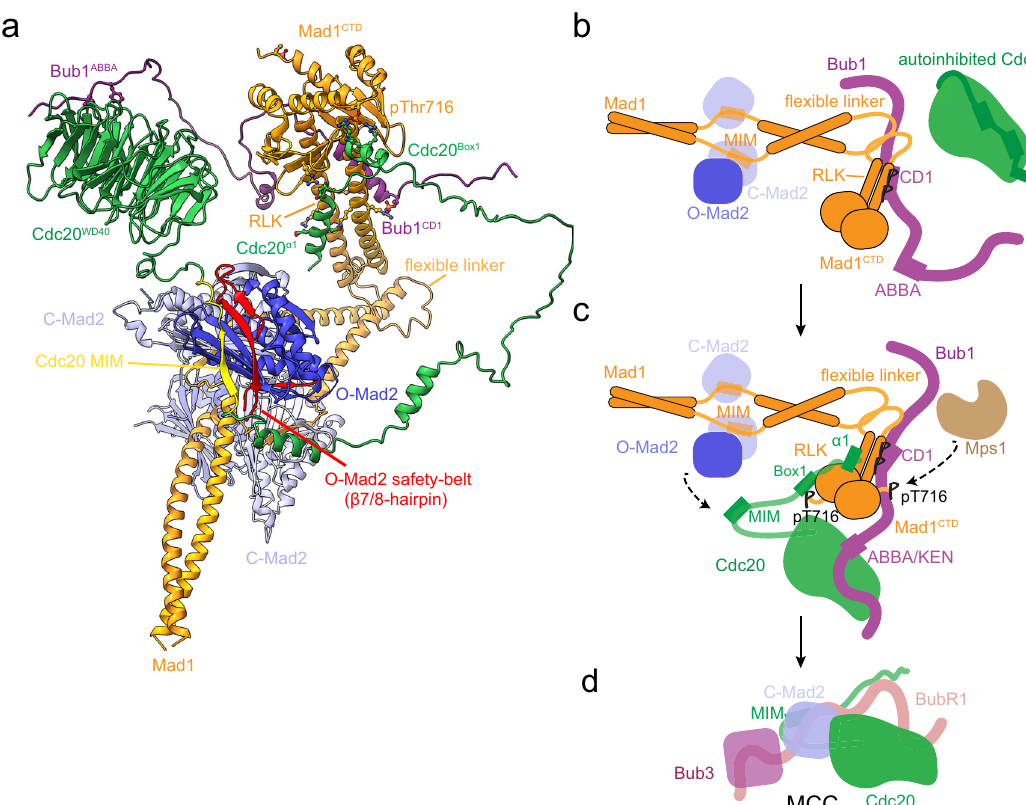
Fig. 8 | A model for how tripartite assembly of pBub1:Cdc20:pMad1 in con- junction with Mad1 CTD fold-over orchestrates MCC formation. a Model of pBub1:Cdc20:pMad1:C-Mad2:O-Mad2complex (MCC-assembly scaffold) posed for MCC formation (Supplementary Movie 1). The model (Supplementary Data 1)